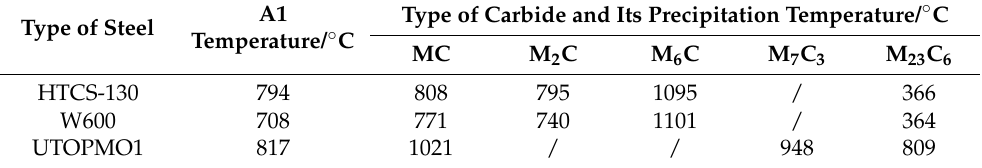
Figure 7. SEM micrographs of the interaction layer of the W600 ( a ), HTCS-130 ( b ), and UTOPMO1 ( c ) tool steel samples. Table 4. A1 temperatures and types of carbides and their precipitation temperature in the investi- gated